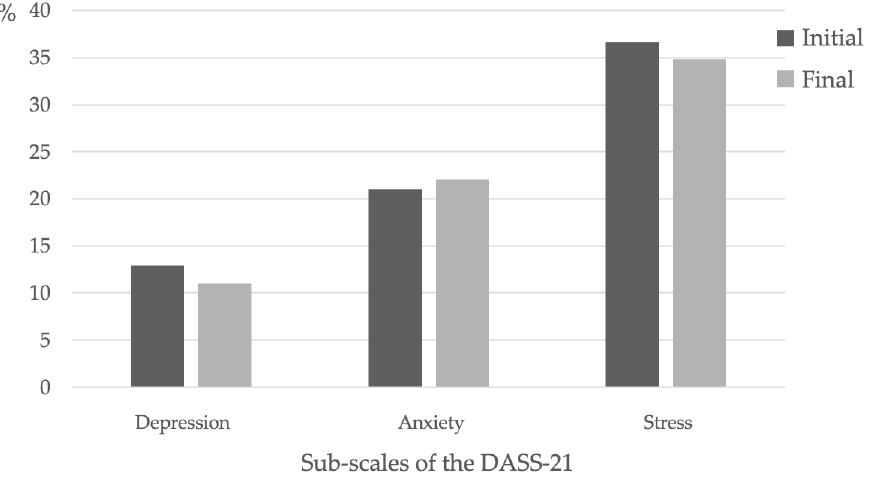
Figure 2. Mean values of the depression, anxiety and stress subscales at the two assessment times.